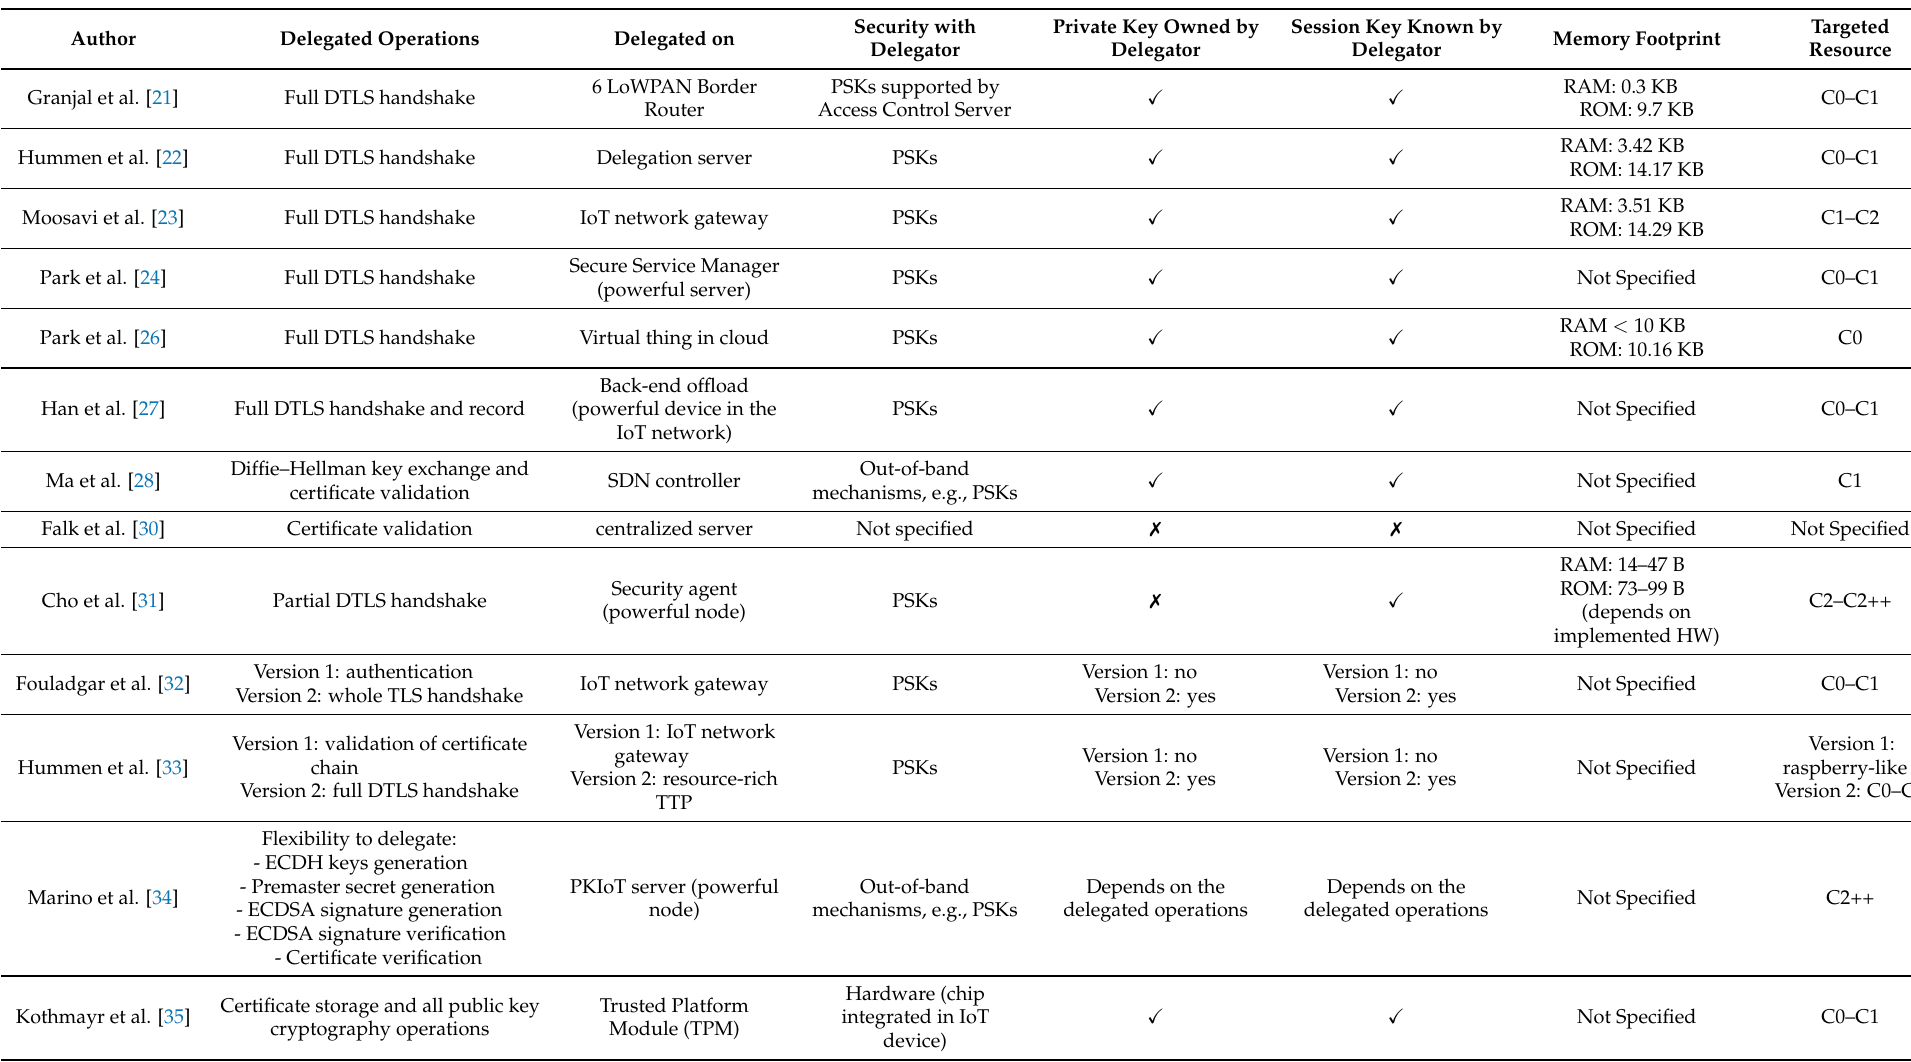
Table 2. Summary of DTLS handshake delegation based